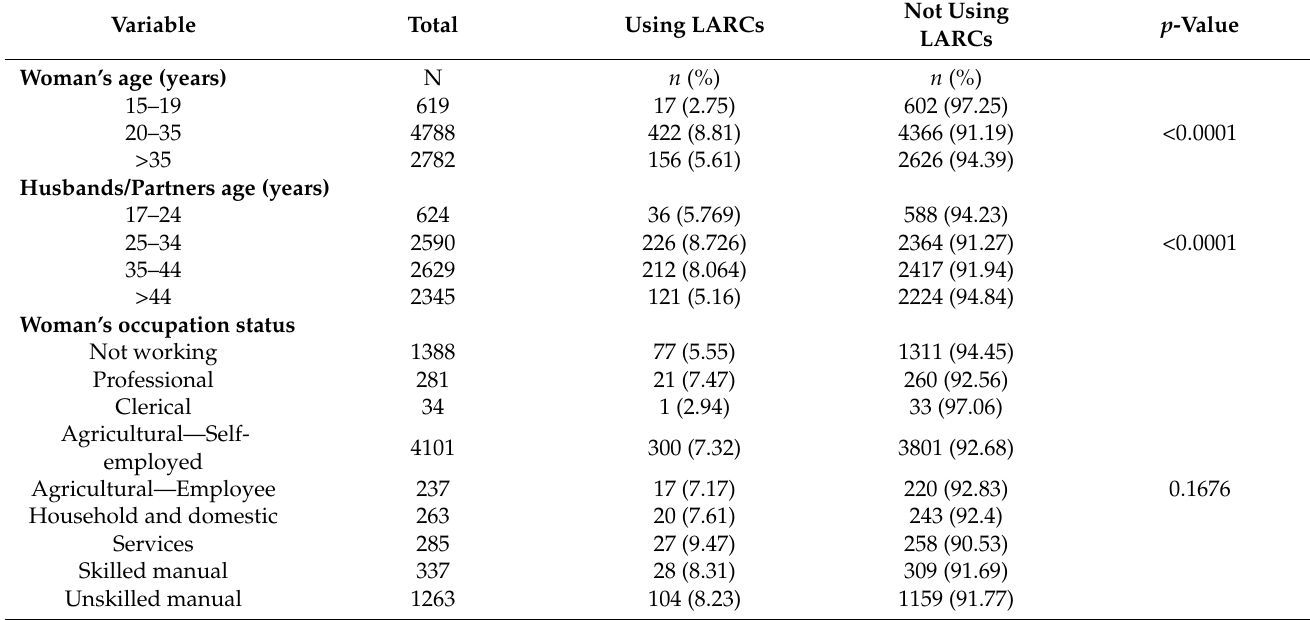
Table 1. Sociodemographic characteristics of participants related to long-acting family planning utilization (N =